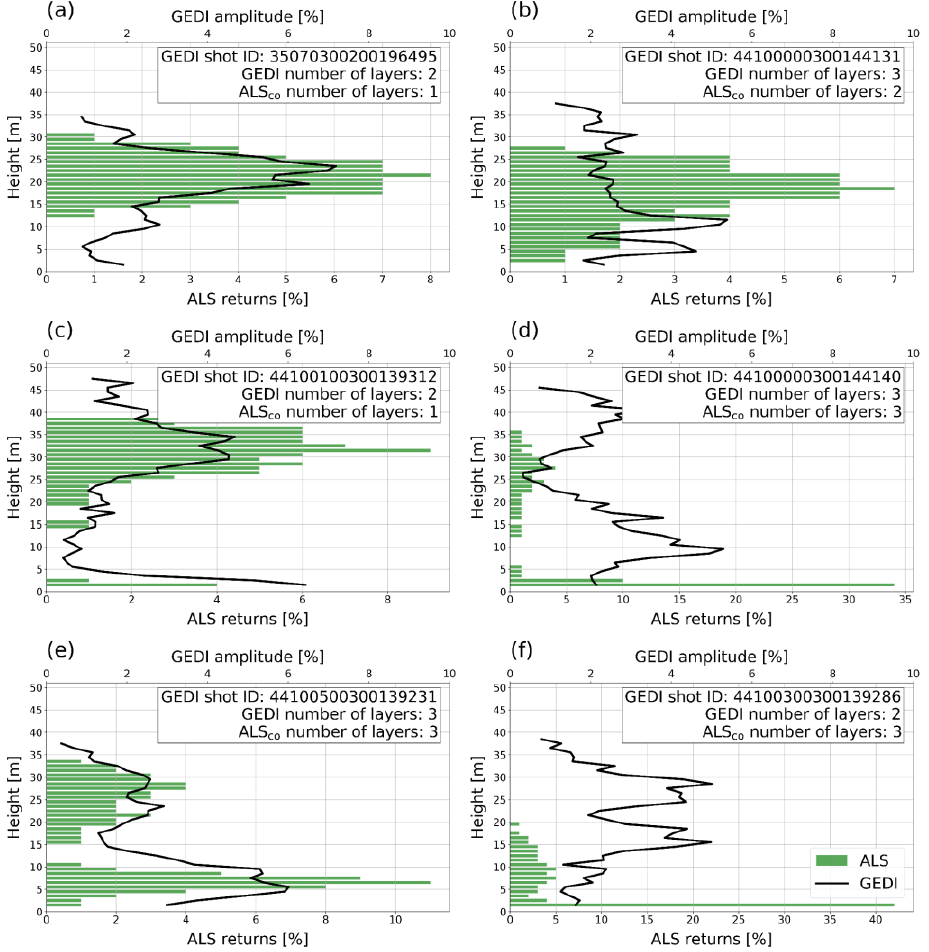
Figure A1. Examples of waveforms from GEDI and ALS: ( a , c , e ): good agreement between ALS and GEDI; ( b , d , f ): poor agreement between ALS and GEDI.